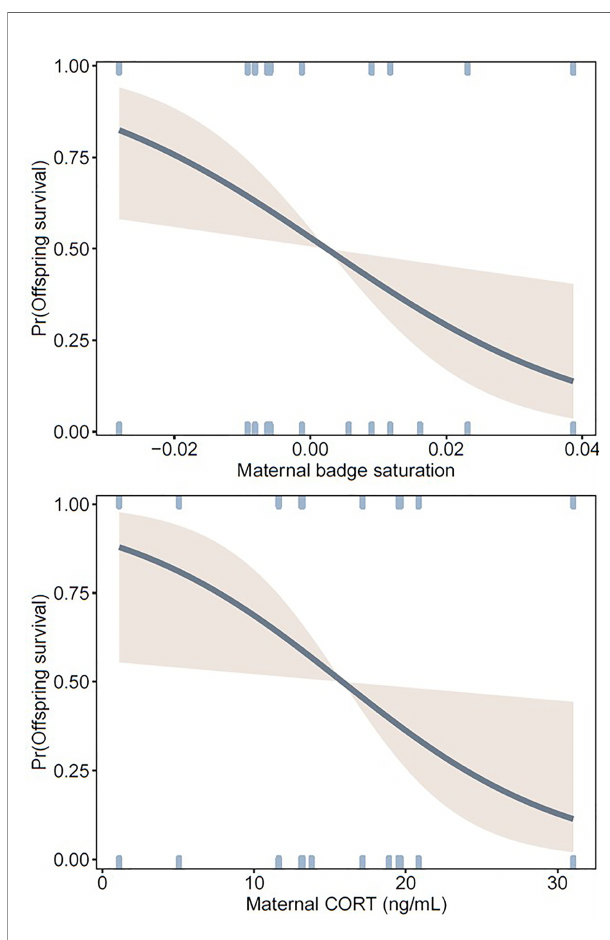
FIGURE 3 | Probability curves showing offspring survival to 323 ± 2 days of age (at which they had reached sexual maturity) in relation to statistically signi fi cant predictors (maternal badge saturation and CORT) in a logistic regression. Other model parameters are shown in Table 1 . Maternal badge saturation was corrected for body temperature at the time of measurement (see Methods ).